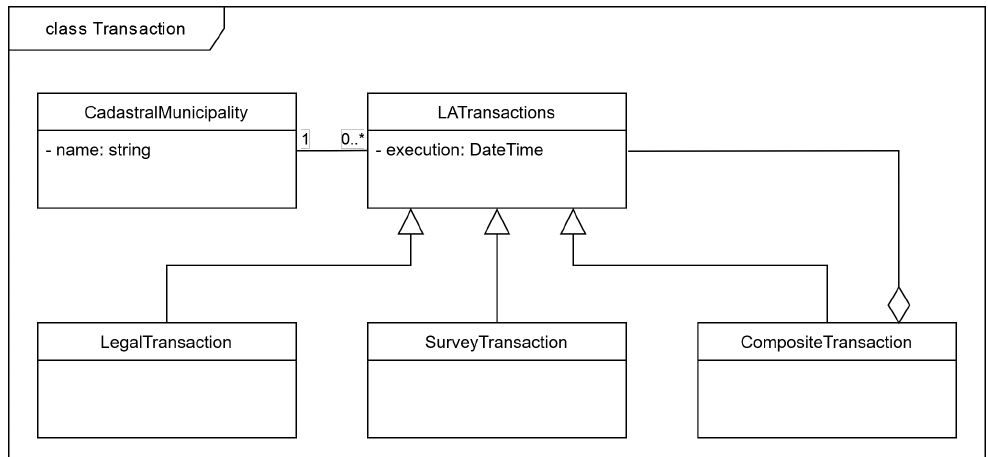
Figure 1. LAS transactions’ key